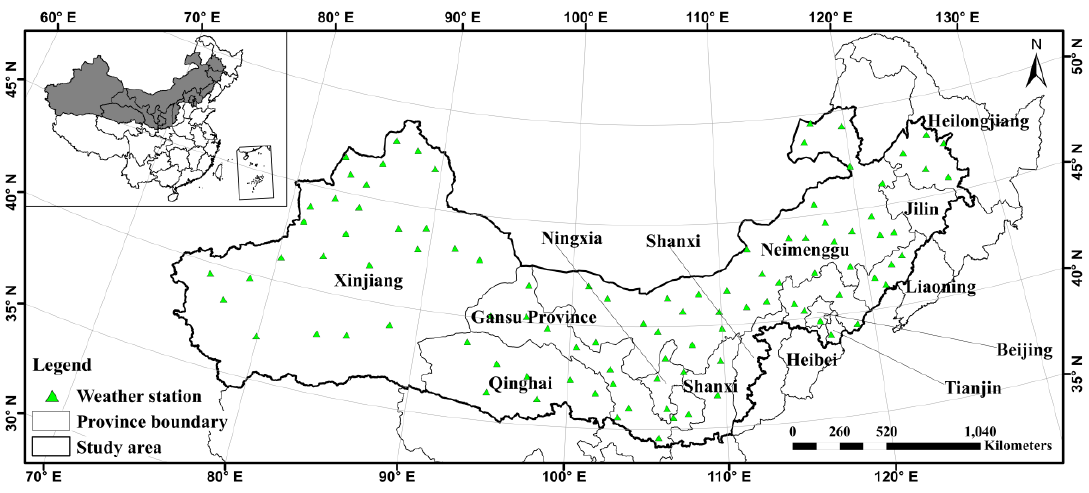
Figure 1. Location map of the study area in China.